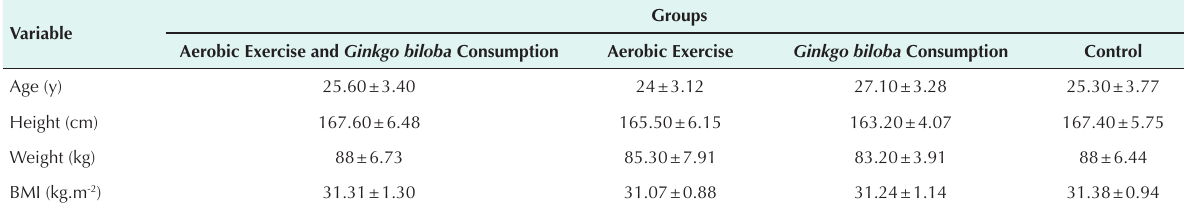
Table 1. Individual Characteristics of the Subjects at the Basic Level Variable